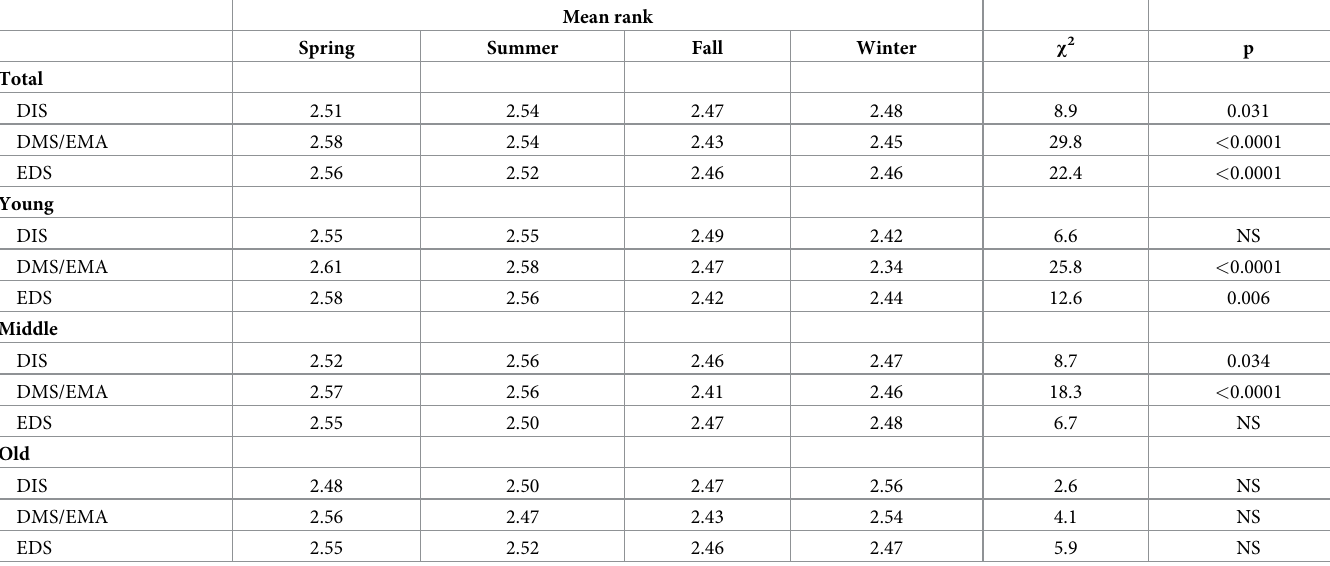
Table 4. Mean ranks of DIS, DMS/EMA, and EDS symptoms for each season by age group.